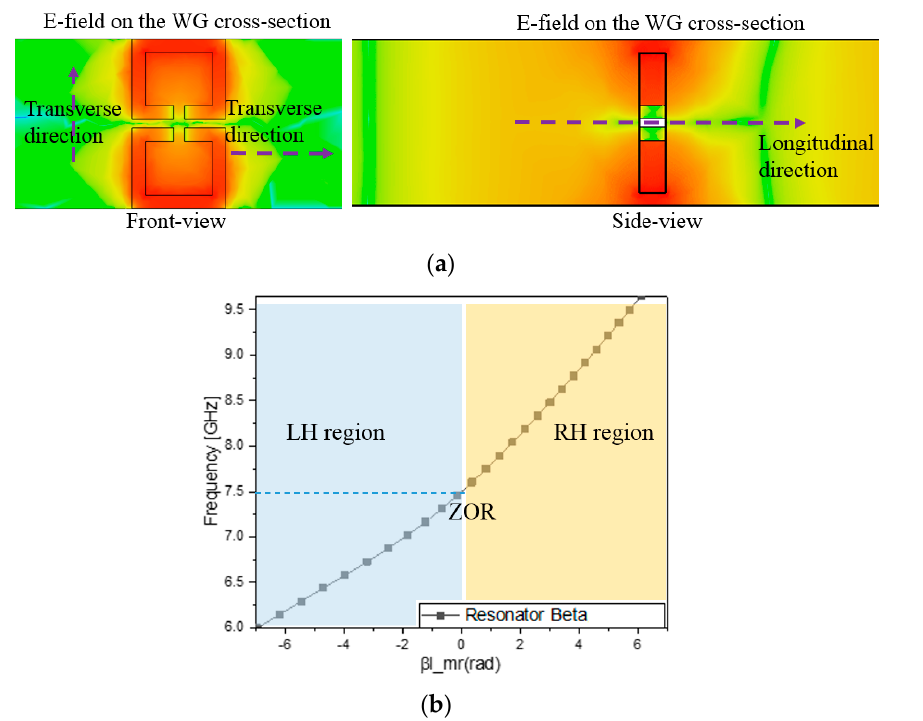
Figure 4. Observing the ZOR of the resonator. ( a ) E − field resonant and confined to a thin plane. ( b ) Dispersion diagram.